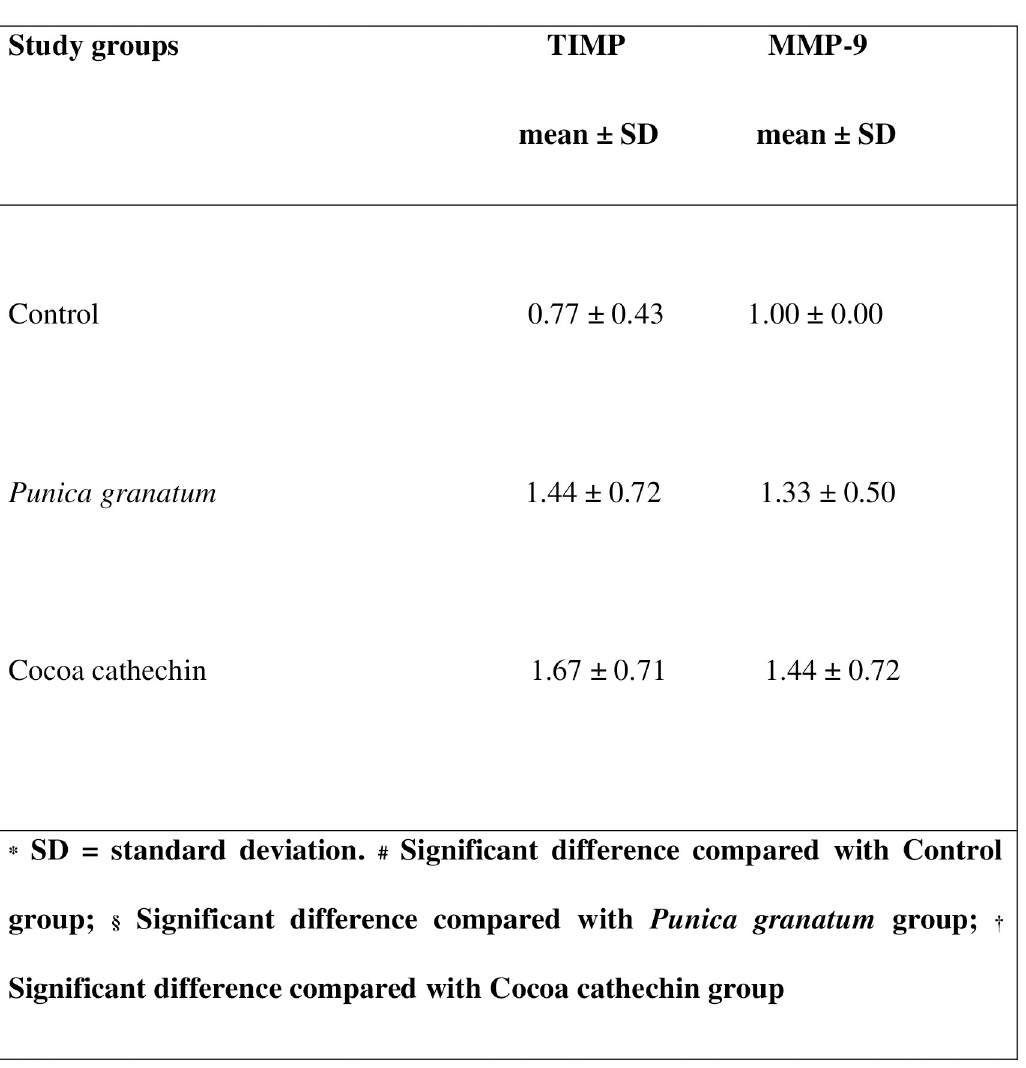
Fig 7. Table of comparison of degree of intensity (0–3) of stained stroma with TIMP and MMP-9 between study groups (Tukey test).